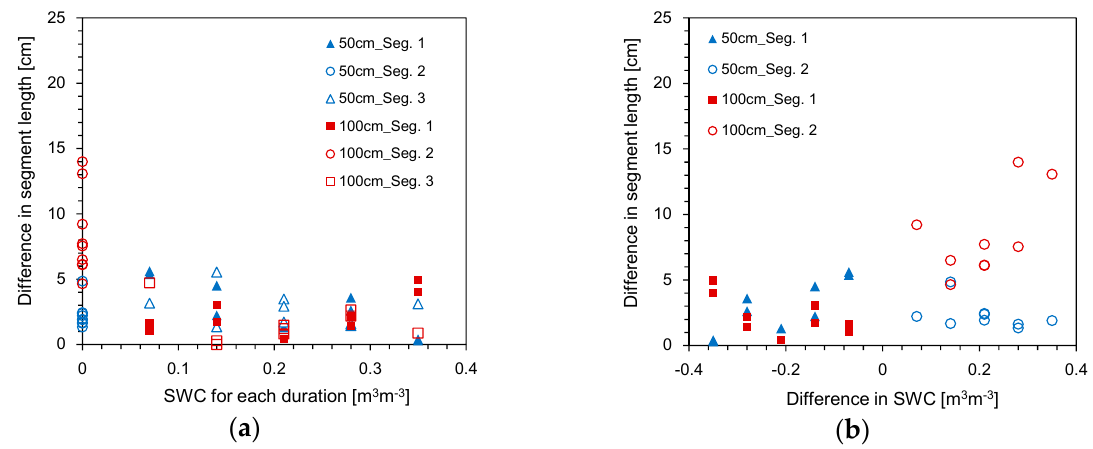
Figure 14. Difference between actual segment length and segment length estimated for each duration in the WDW treatment along; ( a ) SWC; ( b ) difference in SWC.